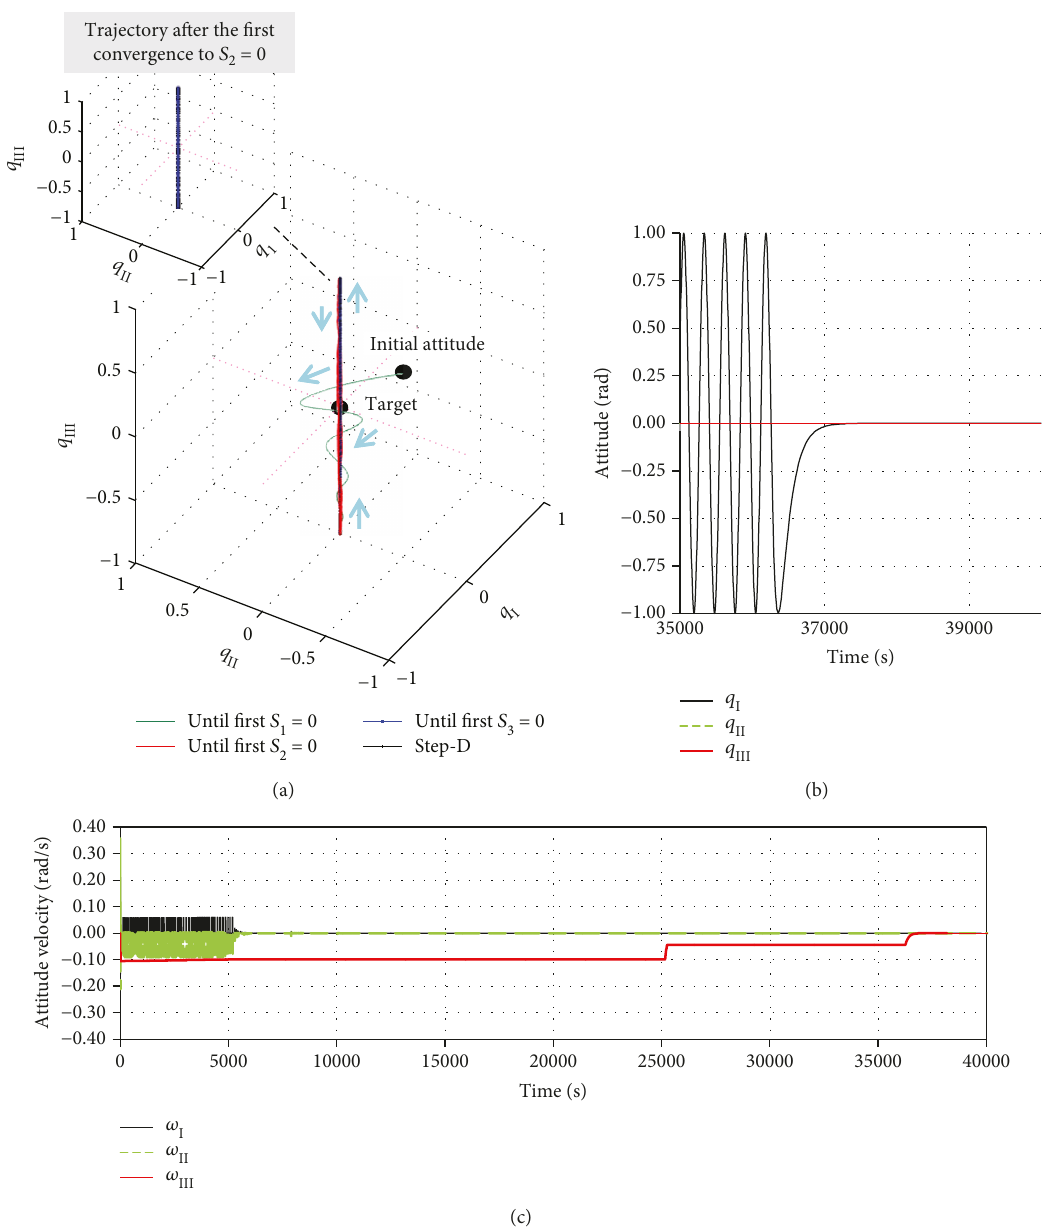
Figure 7: Attitude in case 1. (a) Attitude trajectory to the target. (b) Attitude history around the target. (c) Time history of attitude